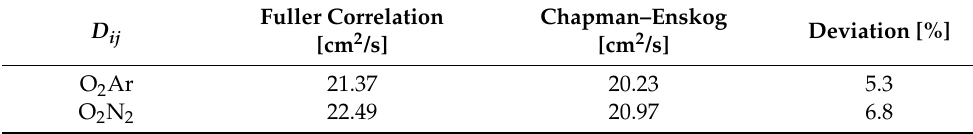
Table 3. Deviation between the binary diffusion coefficients using different models for calculation. Fuller Correlation Chapman–Enskog D ij [cm 2 /s] [cm 2